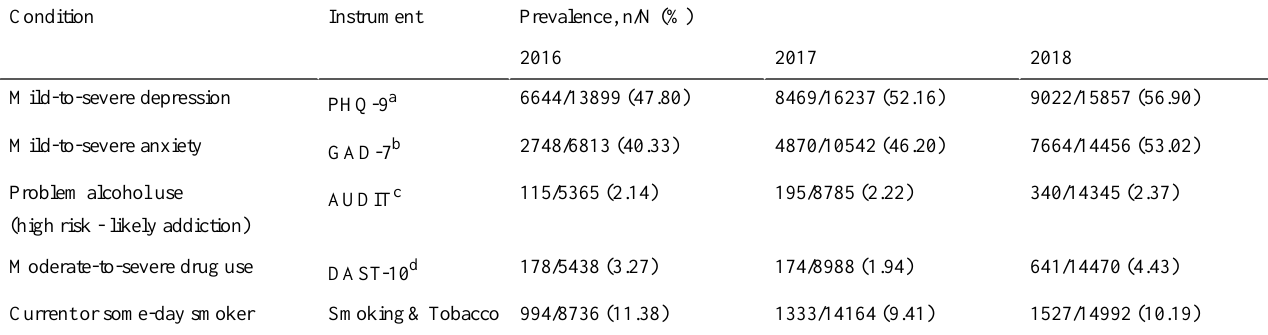
Table 1. Electronic patient-reported outcome (ePRO) prevalence data for